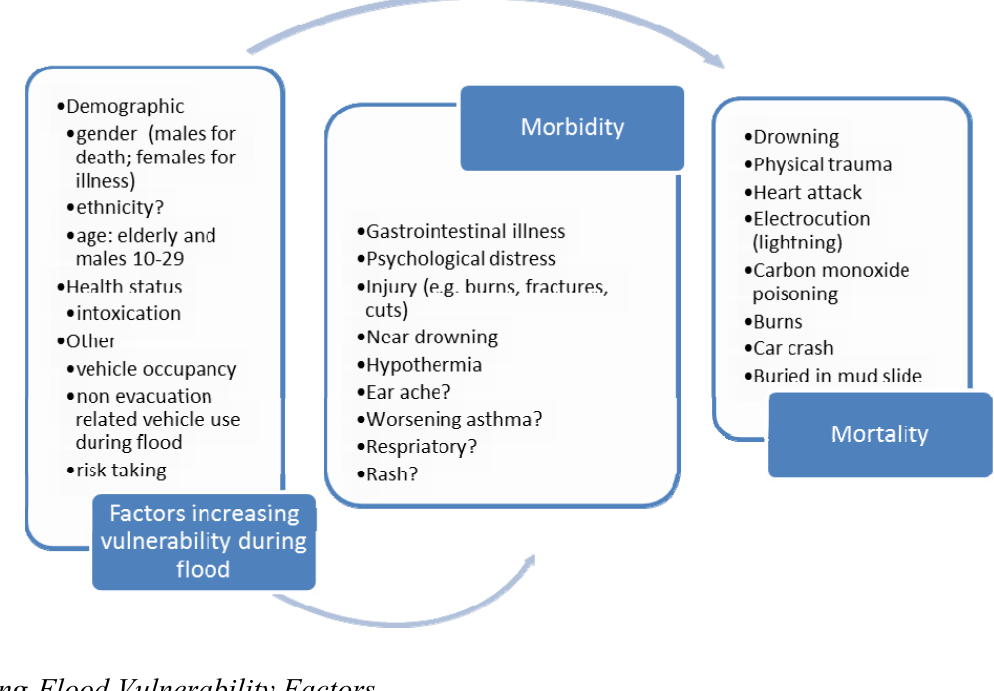
Figure 5. Factors increasing vulnerability to health effects during-flood